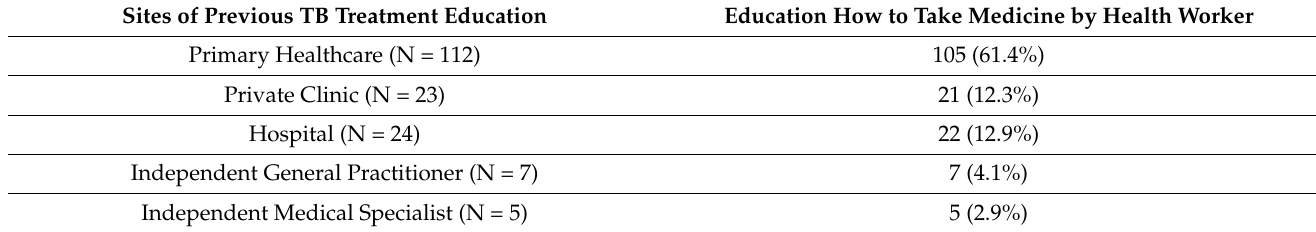
Table 4. Education How to Take Medicine by Health Worker (N =